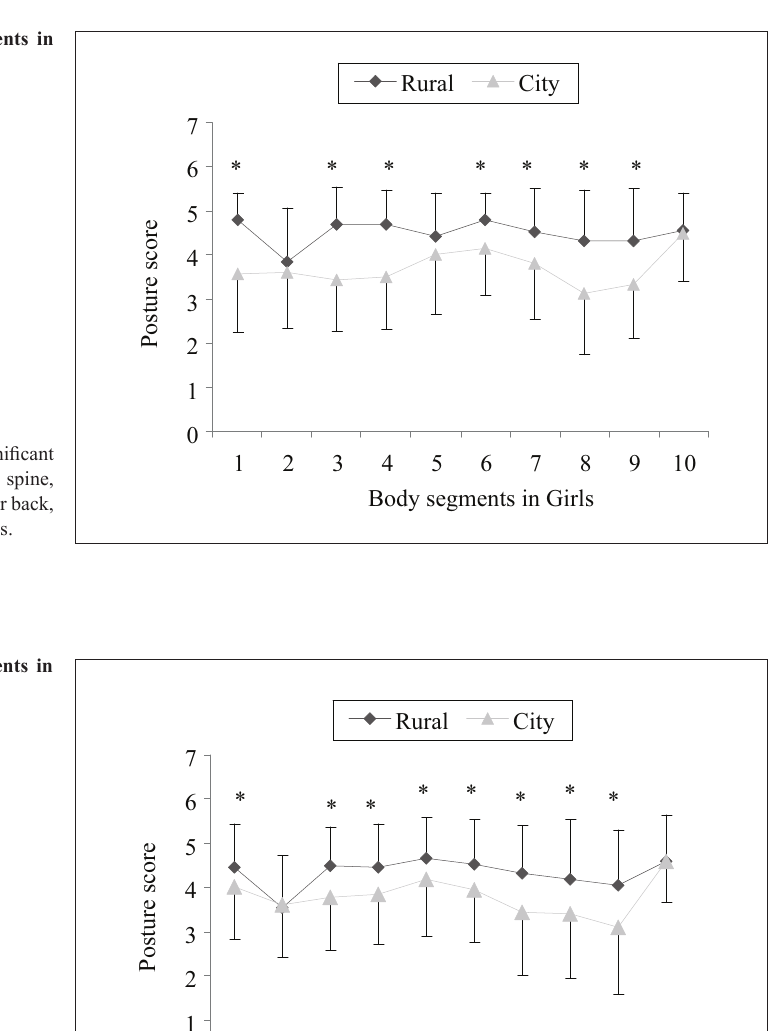
Figure 2. Alignment of different body segments in rural and city girls